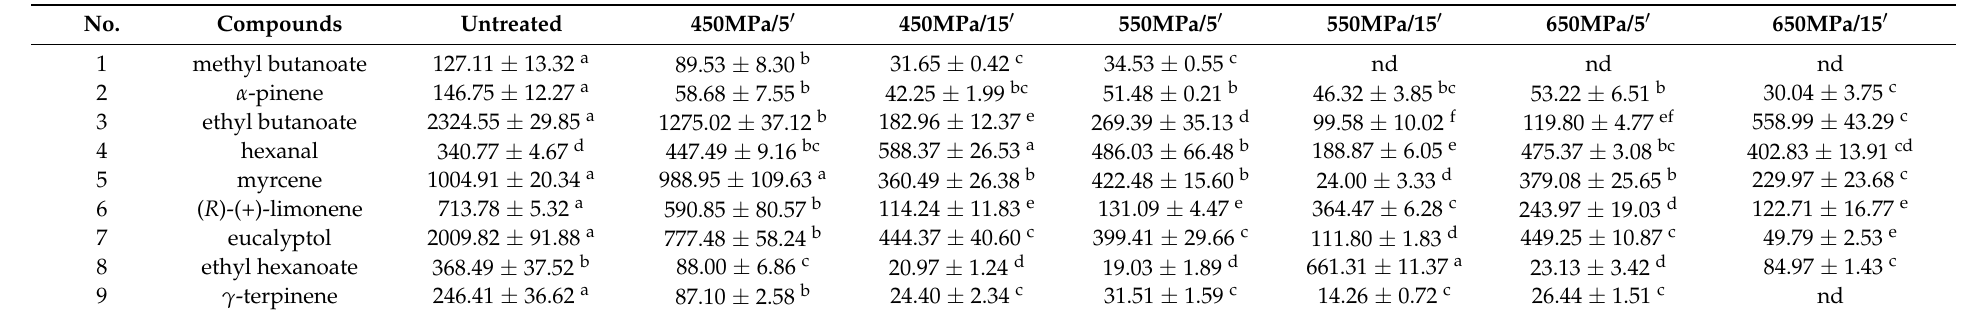
Table 4. The content of major VOCs estimated in the untreated and HHP-treated cv Weiki. Results are presented as µ g per kg of